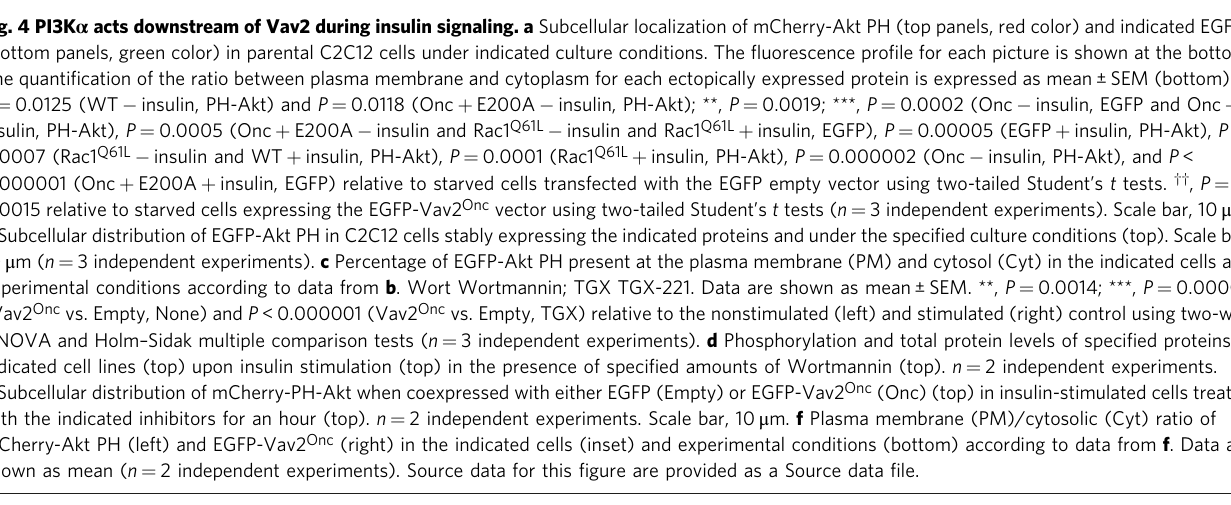
Fig. 4 PI3K α acts downstream of Vav2 during insulin signaling. a Subcellular localization of mCherry-Akt PH (top panels, red color) and indicated EGFPs (bottom panels, green color) in parental C2C12 cells under indicated culture conditions. The fl uorescence pro fi le for each picture is shown at the bottom. The quanti fi cation of the ratio between plasma membrane and cytoplasm for each ectopically expressed protein is expressed as mean ± SEM (bottom). *, P = 0.0125 (WT − insulin, PH-Akt) and P = 0.0118 (Onc + E200A − insulin, PH-Akt); **, P = 0.0019; ***, P = 0.0002 (Onc − insulin, EGFP and Onc + insulin, PH-Akt), P = 0.0005 (Onc + E200A − insulin and Rac1 Q61L − insulin and Rac1 Q61L + insulin, EGFP), P = 0.00005 (EGFP + insulin, PH-Akt), P = 0.0007 (Rac1 Q61L − insulin and WT + insulin, PH-Akt), P = 0.0001 (Rac1 Q61L + insulin, PH-Akt), P = 0.000002 (Onc − insulin, PH-Akt), and P